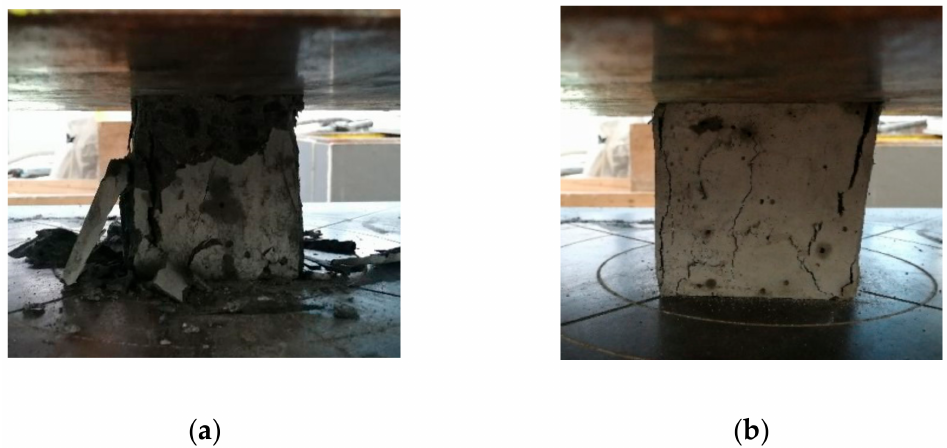
Figure 3. Comparison of compression failure modes of specimens: ( a ) Reference group; ( b ) hybrid fiber